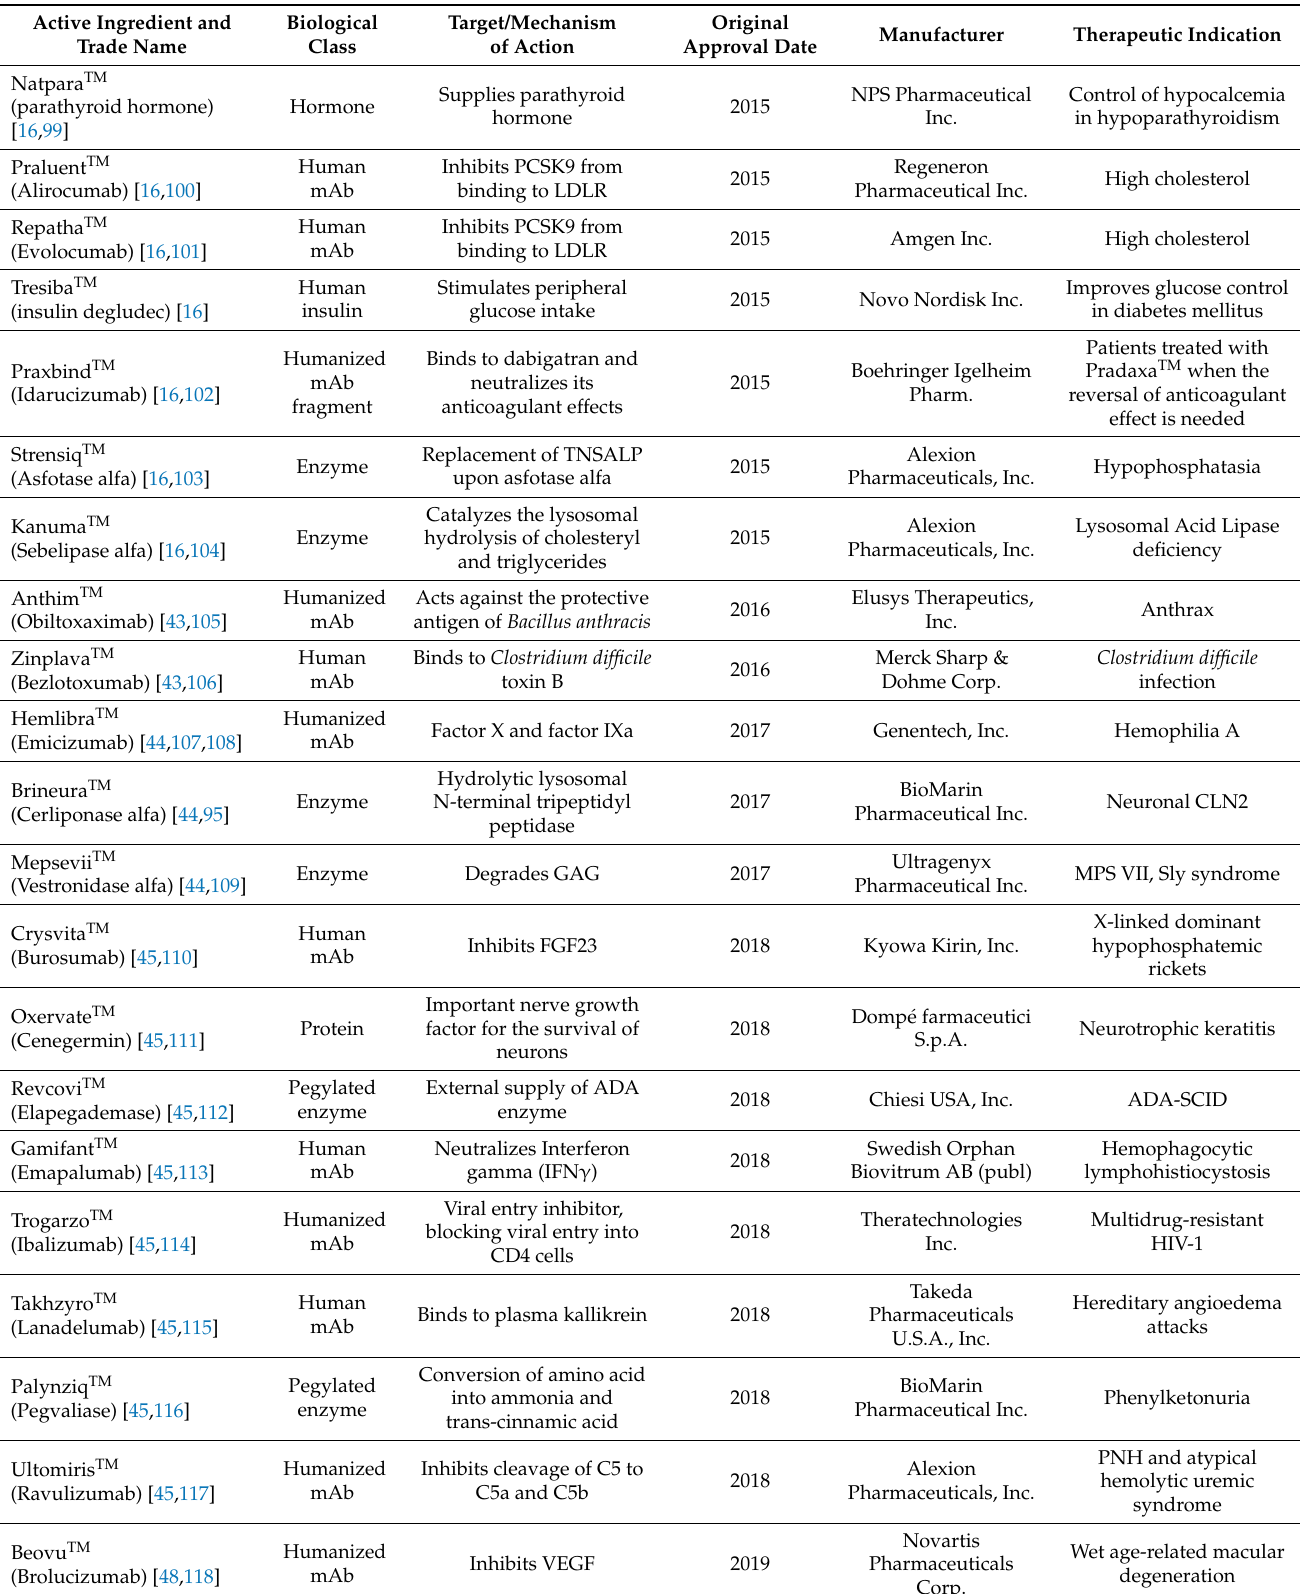
Table 9. Other biologicals approved by the Food and Drug Administration from 2015 to